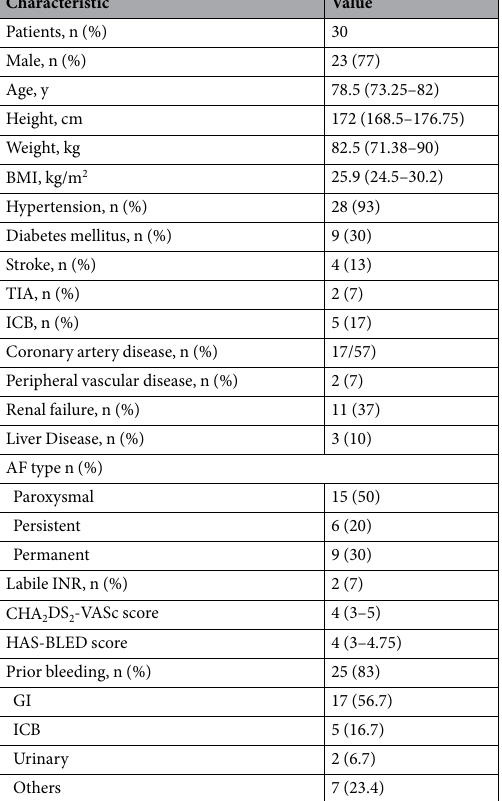
Table 1. Demographic and clinical baseline characteristics of the study cohort. Values are given as medians (1. and 3. quartile) or as total number (percentage). Abbreviations: GI: gastrointestinal; AF: atrial fibrillation; OAC: oral anticoagulation, INR: international normalized ratio; ICB: intracranial bleeding; TIA: transient ischemic